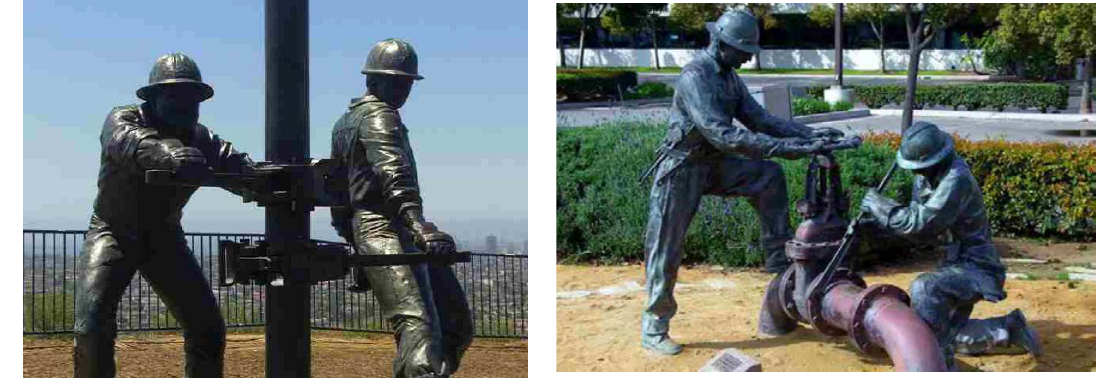
Fig. 1 a sculpture two bronze roughnecks , by the artist Cindy Jackson, SIGNAL HILL, California, USA